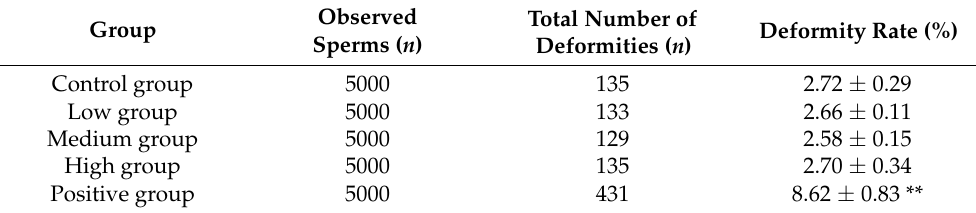
Table 2. Effect of enzyme solution on the incidence of sperm malformation in mice.